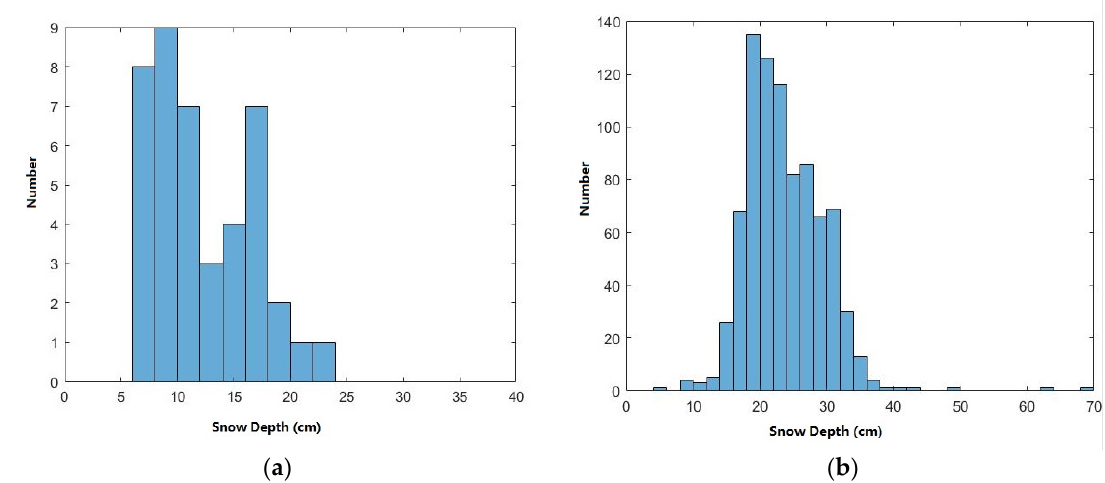
Figure 17. Histogram of snow depths for verification. ( a ) FYI; ( b ) MYI.